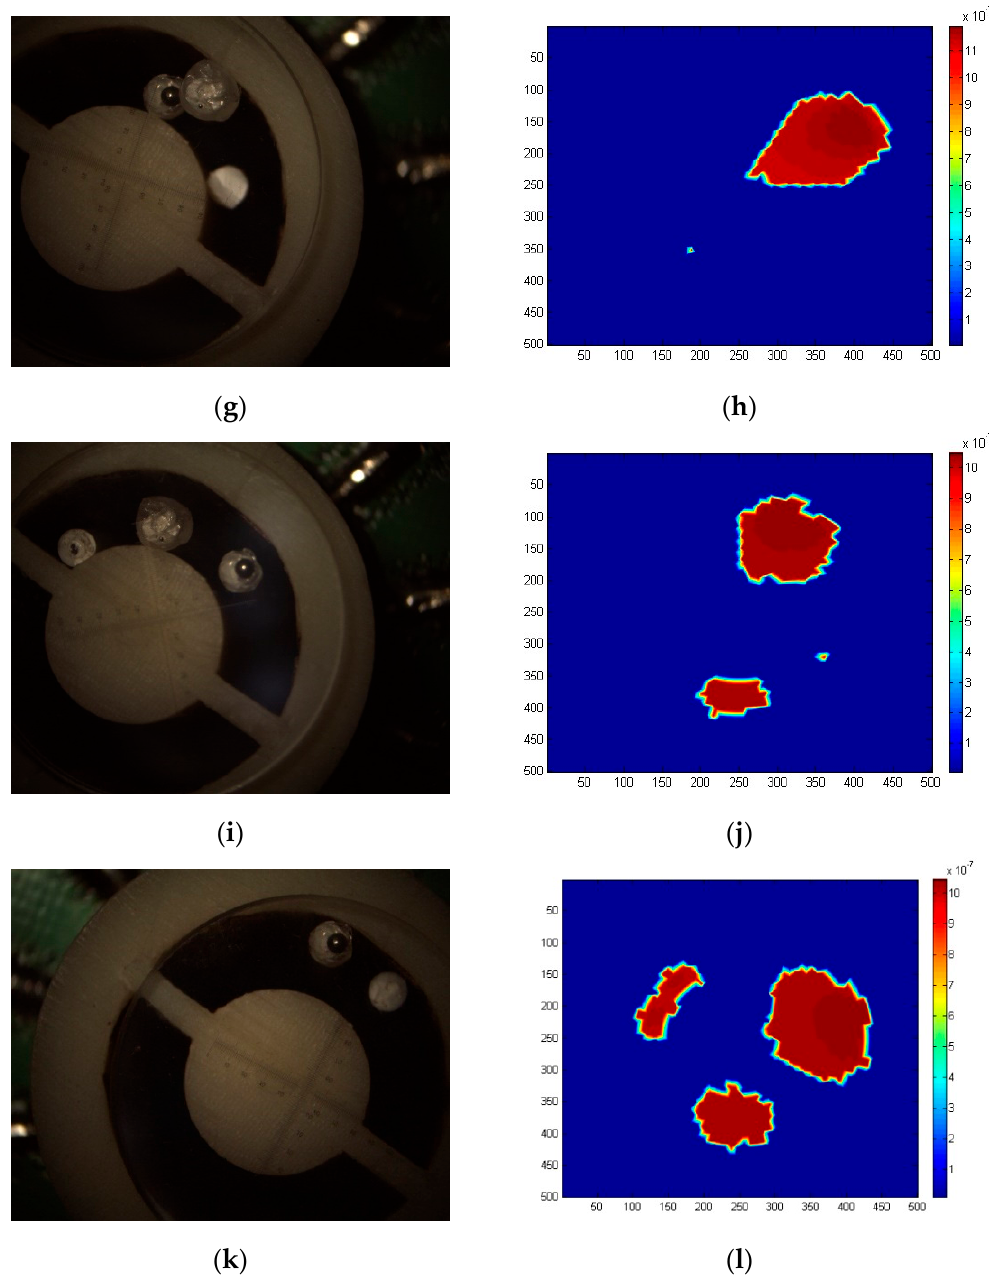
Figure 9. Debris imaging of CCD and capacitance array inversion methods. ( a ) Single 200 µ m debris CCD image. ( c ) Single 500 µ m debris CCD image. ( e ) Two small debris (separated from each other) CCD images. ( g ) Two adjacent debris (1 big and 1 small) CCD image. ( i ) Three debris (separated from each other) CCD image. ( k ) Three adjacent debris CCD image. ( b , d , f , h , j , l ) Corresponding capacitance array inversion.